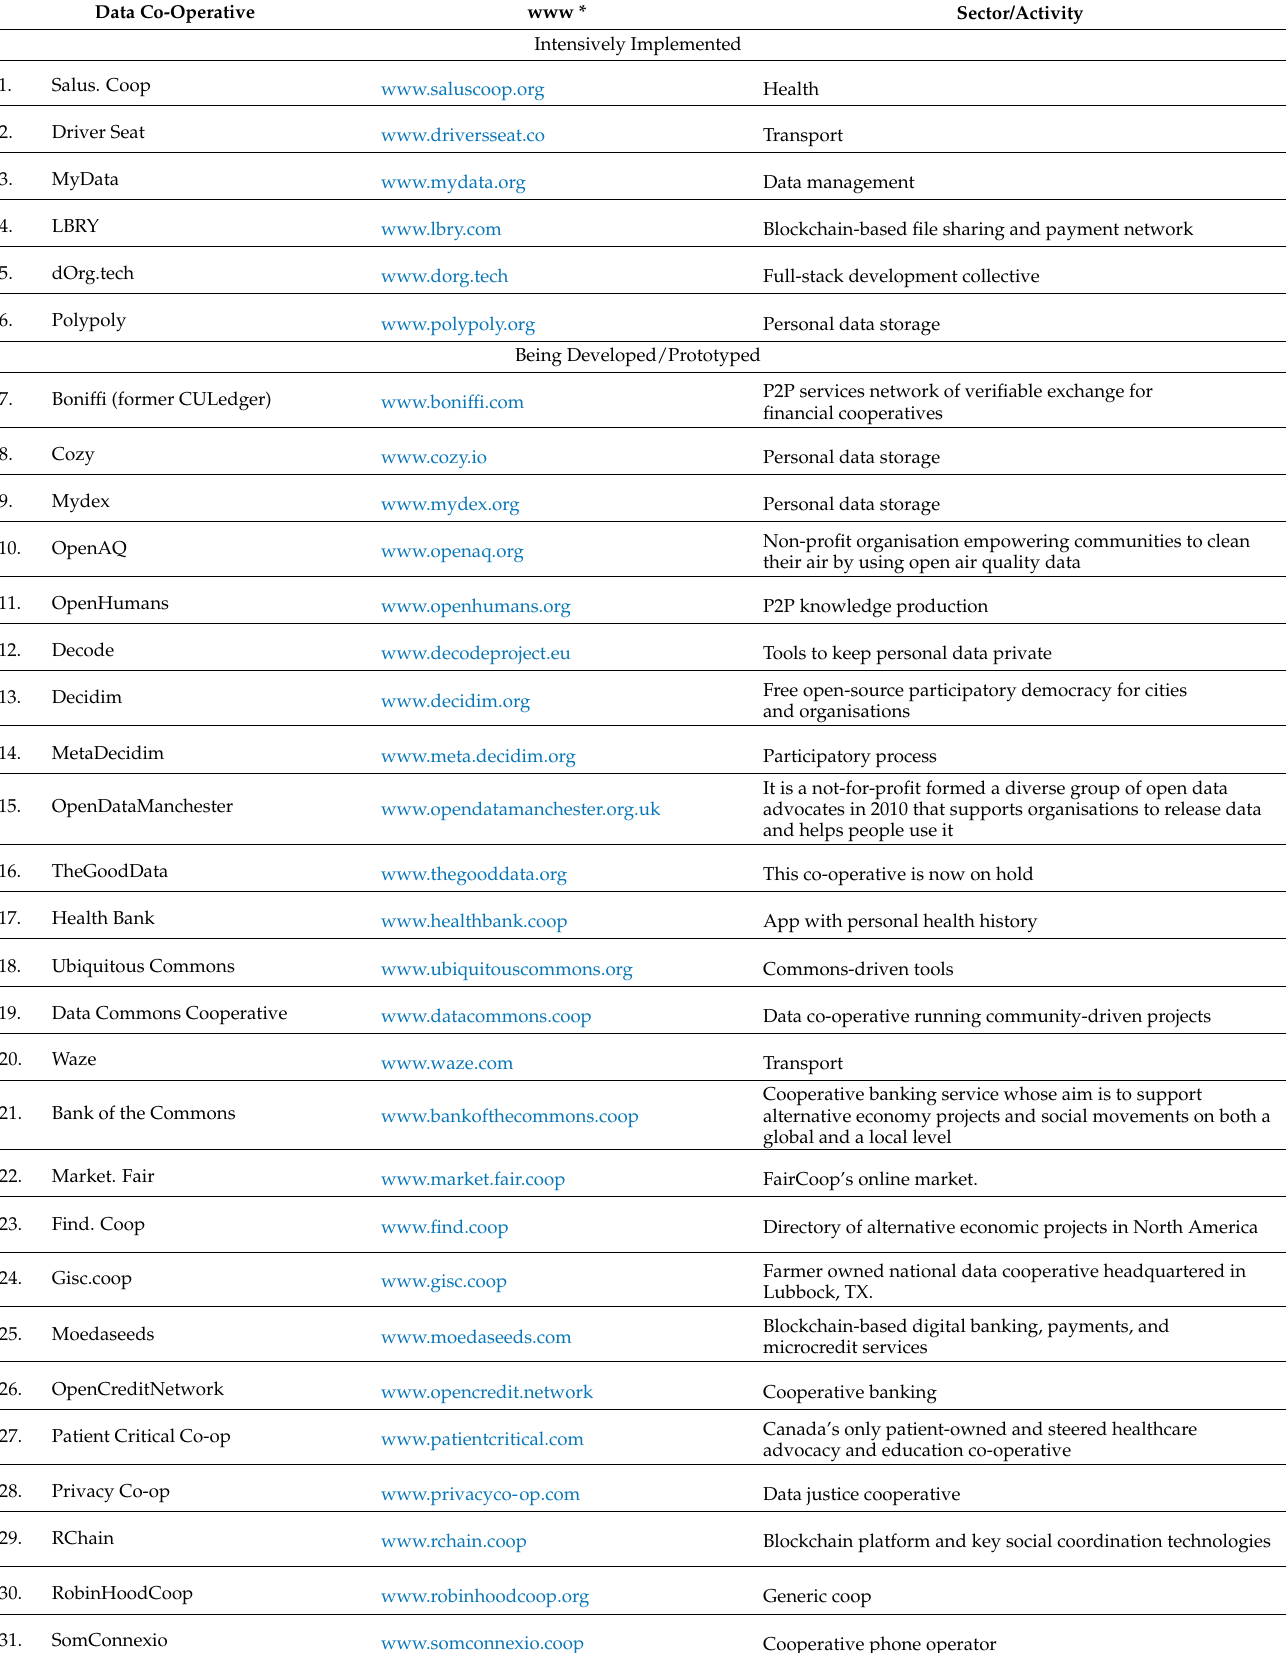
Table 1. Data co-operatives: empirical